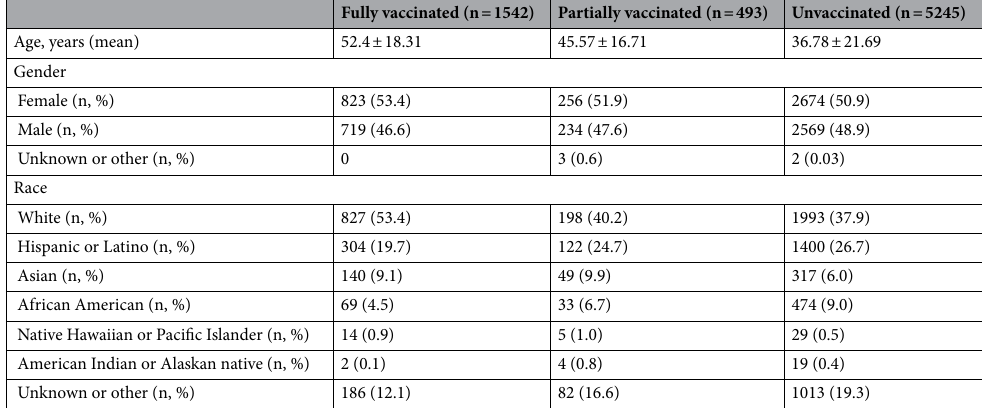
Table 3. Demographic information of patients with a positive SARS-CoV-2 result during the Delta variant wave (n = 7280 SARS-CoV-2 infections).